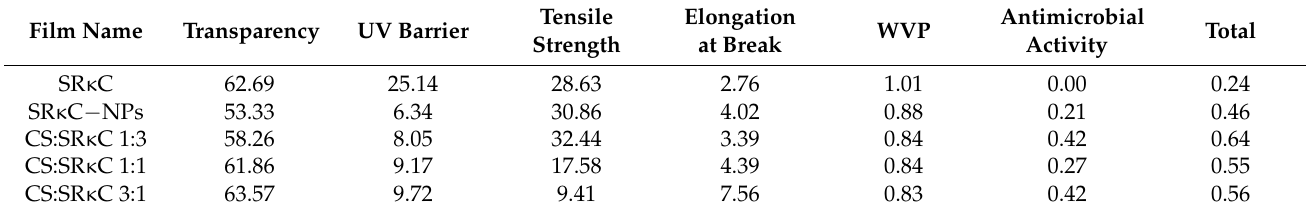
Table 4. Determination of the best film type using several variables.